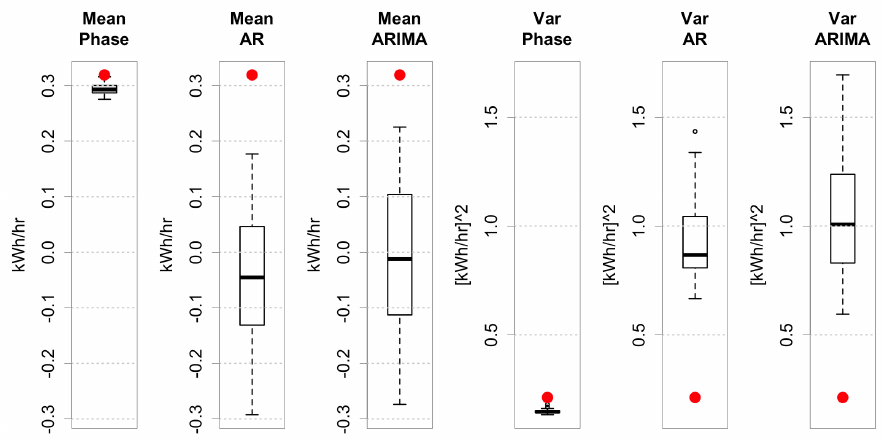
Figure 15. Boxplots of mean and variance comparing the performance of reconstruction methods in simulating the 5 a.m. hourly energy usage by the electric DHW heater in RBSA home 13088, from Q2 2012–Q1 2013 inclusive. Statistics of empirical observations are denoted by red dots. For mean and variance, phase randomization provided superior performance.